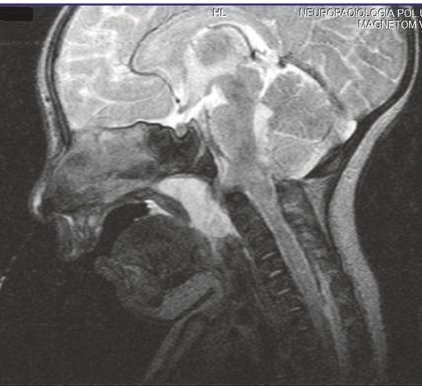
Figure 3: Sagittal T2W MRI of the skull shows a basal occipital meningoencephalocele with protrusion toward the naso- and oro- pharynx. The content of this malformation was primarily fluid with a small quantity of impacted bulb brain